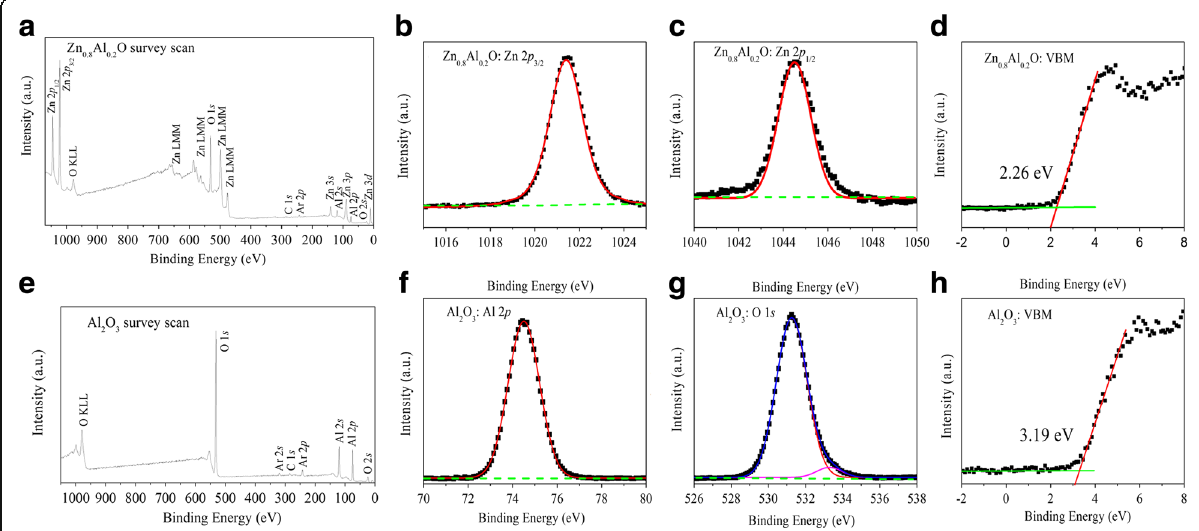
Fig. 3 XPS spectra for a survey scan, b Zn 2 p 3/2 , c Zn 2 p 1/2 , and d VBM of Zn 0.8 Al 0.2 O and e survey scan, f Al 2 p , g O 1 s , and h VBM of Al 2 O 3 , with application of a low-energy electron flood gun